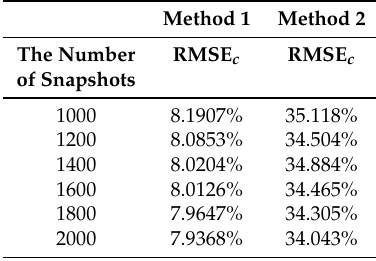
Table 3. RMSE of c 1 versus the number of snapshots when SNR = 5